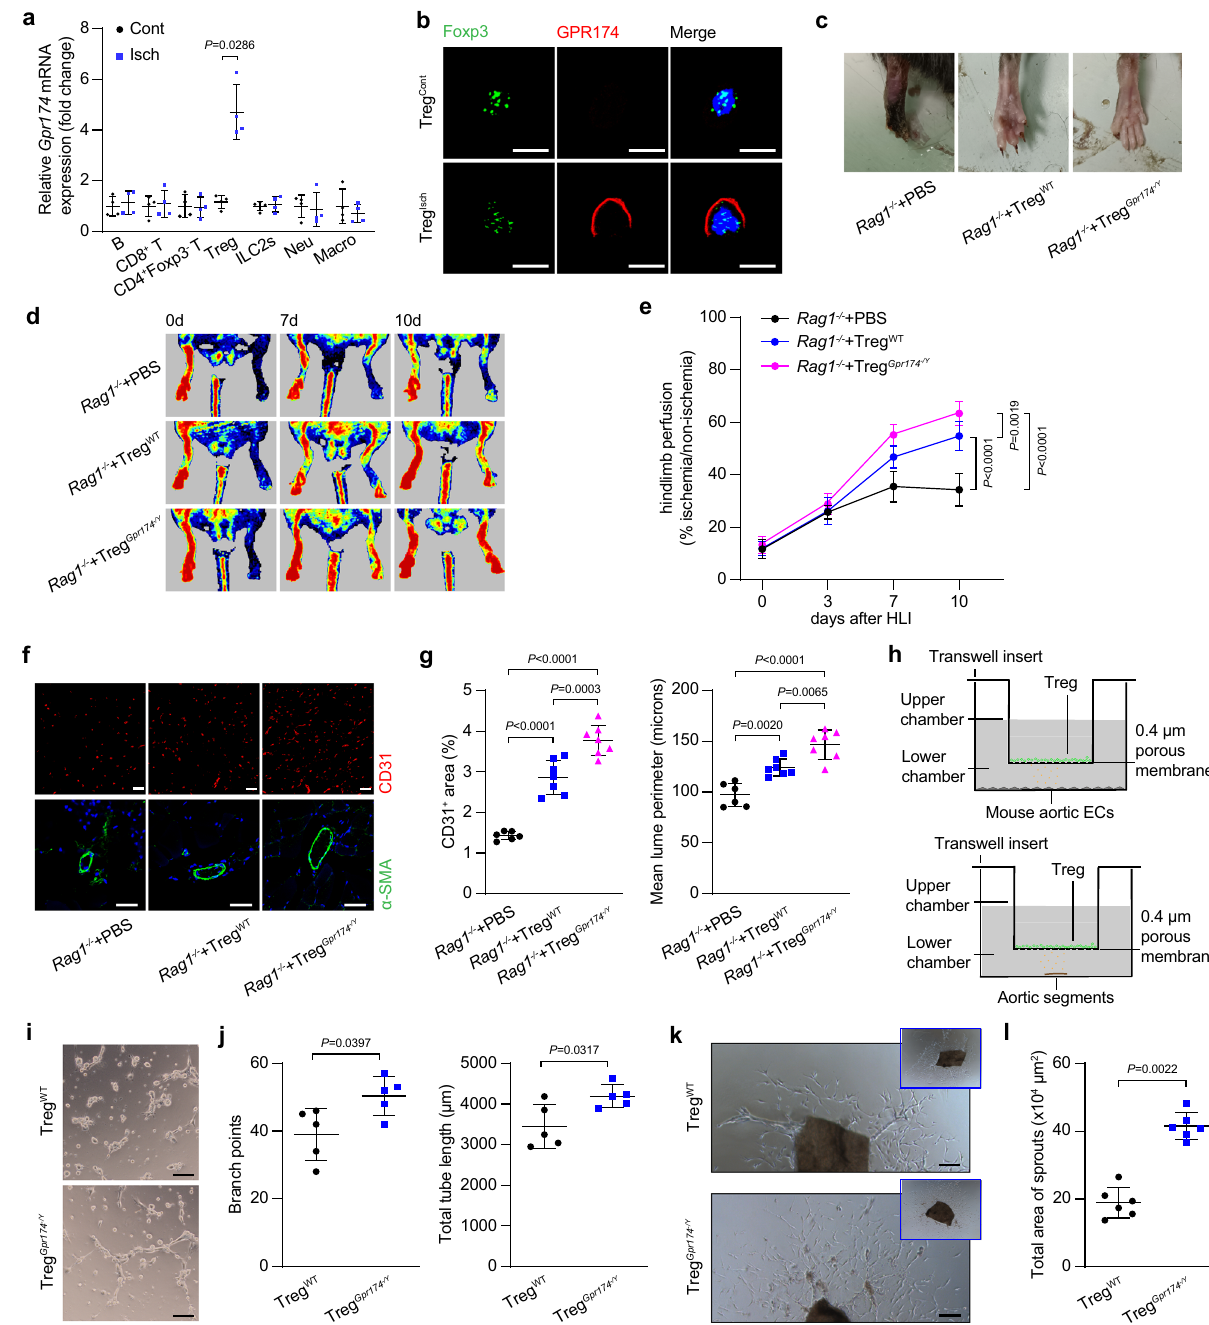
Fig. 2 | GPR174-de fi cient Tregs improve blood fl owrecovery afterHLI.a Gpr174 mRNA expression in B cells, CD8 + T cells, CD4 + Foxp3 − T cells, CD4 + Foxp3 GFP Tregs, ILC2s, neutrophils, and macrophages isolated from non-ischemic and ischemic muscle in WTmice( n =4). b Representative immuno fl uorescent imagesof GPR174 (red), Foxp3 (green), and DAPI (blue) in CD4 + Foxp3 GFP Tregs isolated from non- ischemic and ischemic muscle in WT mice. Scale bar, 10 μ m. c Representative images of necrotic limb 7 days after Tregs adoptive transfer. d , e Representative Laser Doppler images and quanti fi cation of hindlimb blood perfusion in Rag1 − / − mice upon WT or GPR174-de fi cient Tregs ( n =6 for PBS → Rag1 − / − mice; n =7 for wild-type Tregs → Rag1 − / − mice; n =7 for GPR174-de fi cient Tregs → Rag1 − / − mice). f Representative immuno fl uorescent images of CD31(red) (upper panels) and α SMA (green) (lower panels) and DAPI (blue) staining in ischemic muscle cross sections. Scale bar, 50 μ m. g Quanti fi cation of CD31 (left) and lumen perimeter